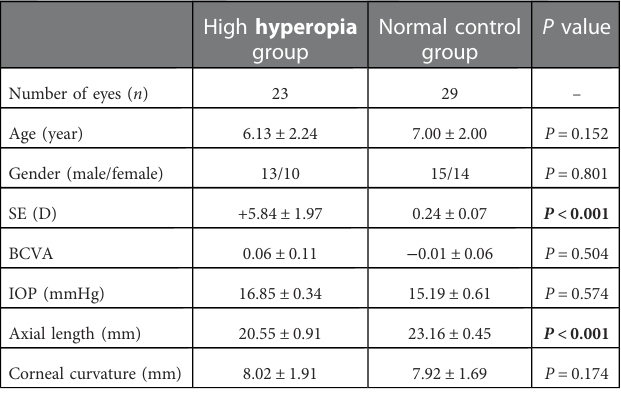
TABLE 1 Demographic and clinical characteristics of enrolled participants ( n